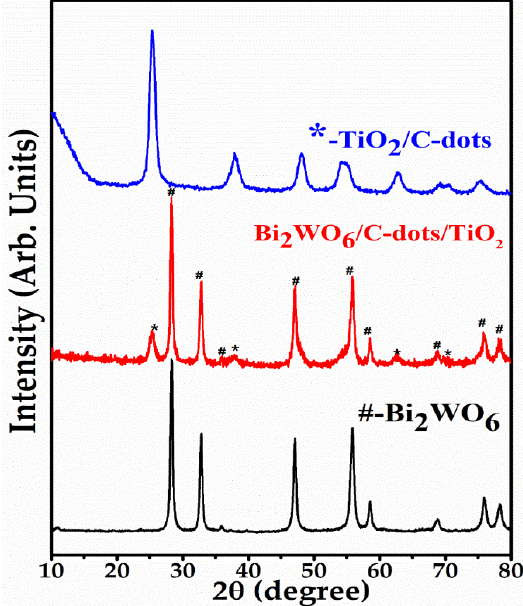
Figure 1. XRD spectra of Bi 2 WO 6 (#), TiO 2 /C-dots (*), and Bi 2 WO 6 /C-dots/TiO 2 .